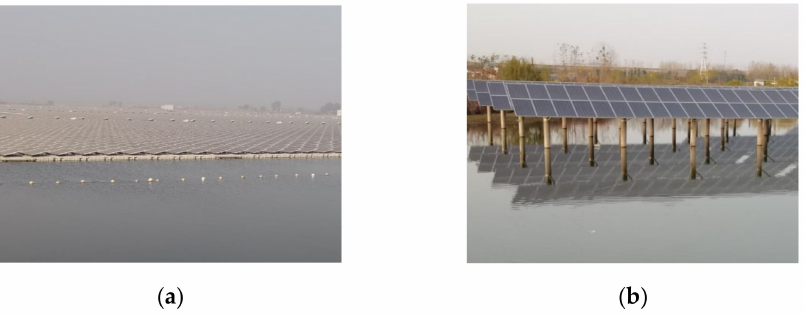
Figure 1. Subsidence pond with different photovoltaic cover systems: ( a ) subsidence pond with a floating photovoltaic cover; ( b ) subsidence pond with a pillaring photovoltaic